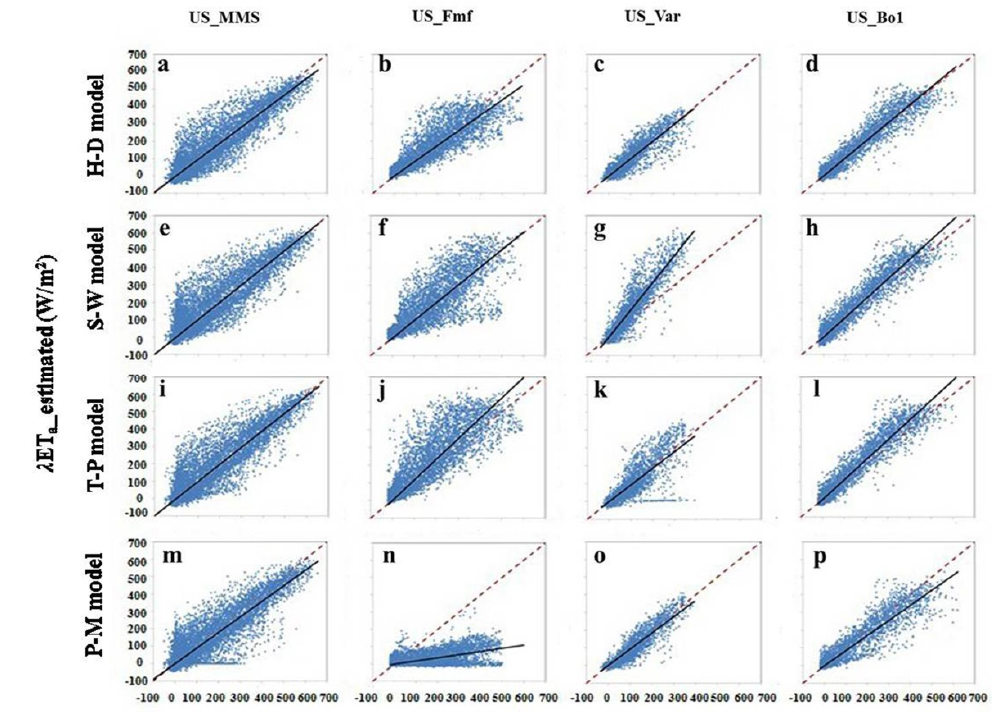
Figure 3. Comparisons of actual evapotranspiration (W/m 2 ) estimates from four models to the eddy covariance measurements over a 30-min period in four different ecosystems (( a – d ): the H-D model; ( e – h ): the S-W model; ( i – l ): the T-P model and ( m – p ): the P-M